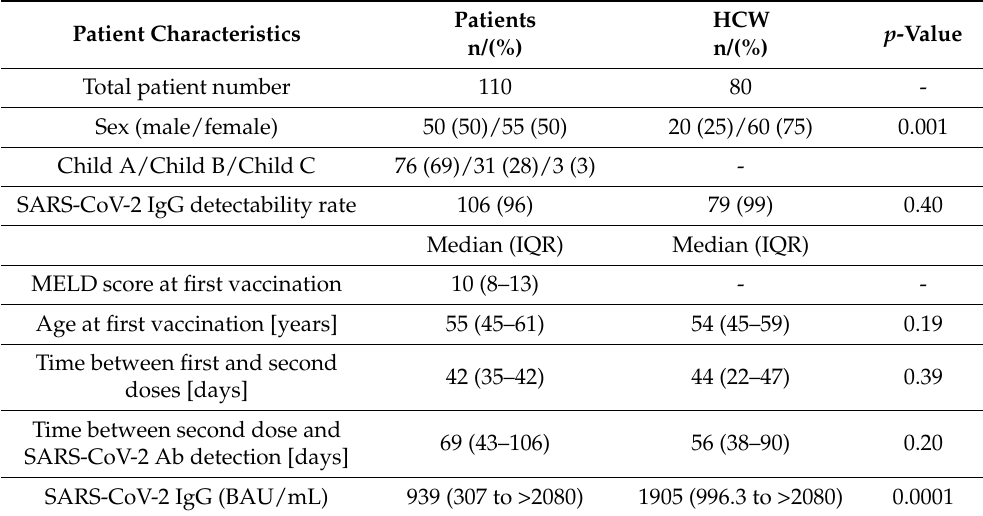
interquartile range. Patient Characteristics